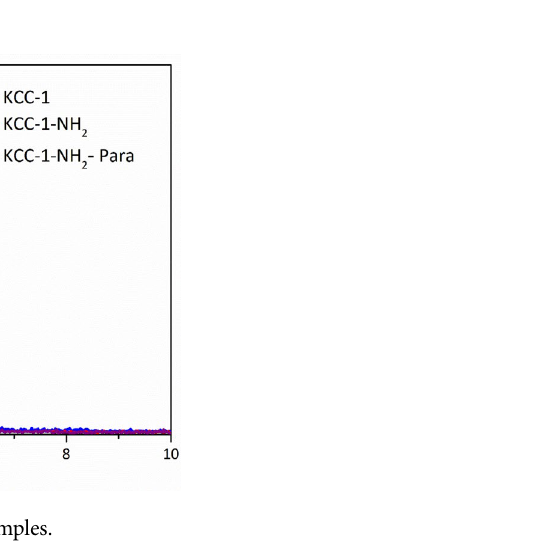
Figure 5. TGA curves of KCC-1 and KCC-1-NH 2 under N 2 atmosphere from 25 to 800 °C at a heating rate of 10 °C/min −1 .